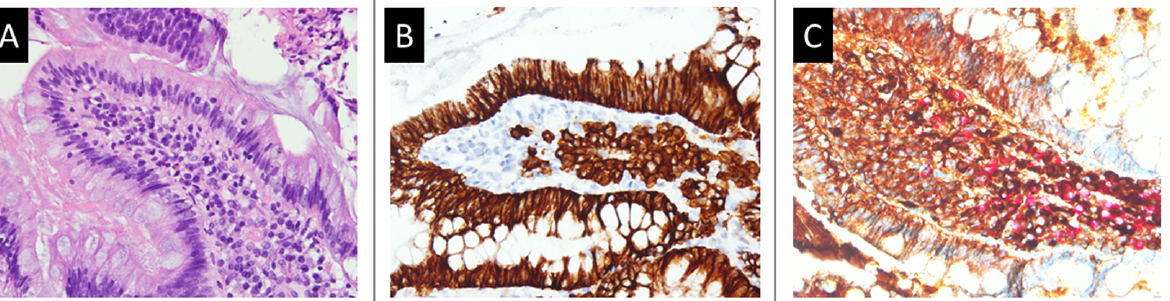
Figure 3. Histology findings of the endoscopic biopsied tissues. ( A ) Plasma cells aggregate in the